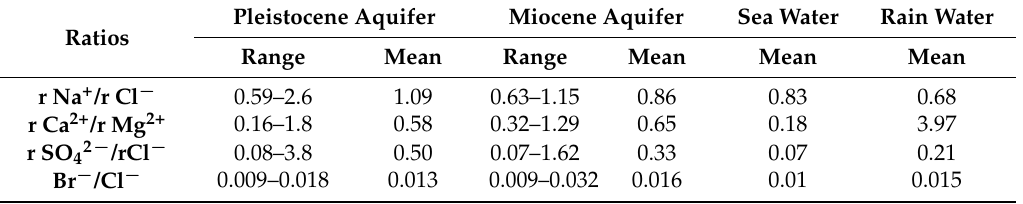
Table 1. Ranges and mean values of hydrochemical ratios of the different aquifers in the study area. Pleistocene Aquifer Miocene Aquifer Sea Water Ratios